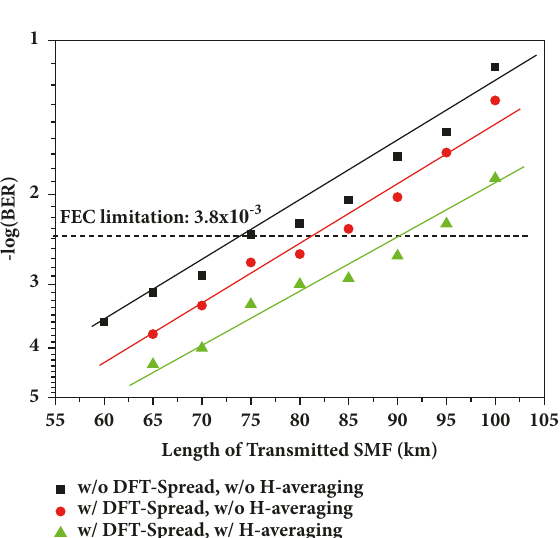
Figure 6: BER versus distances with different